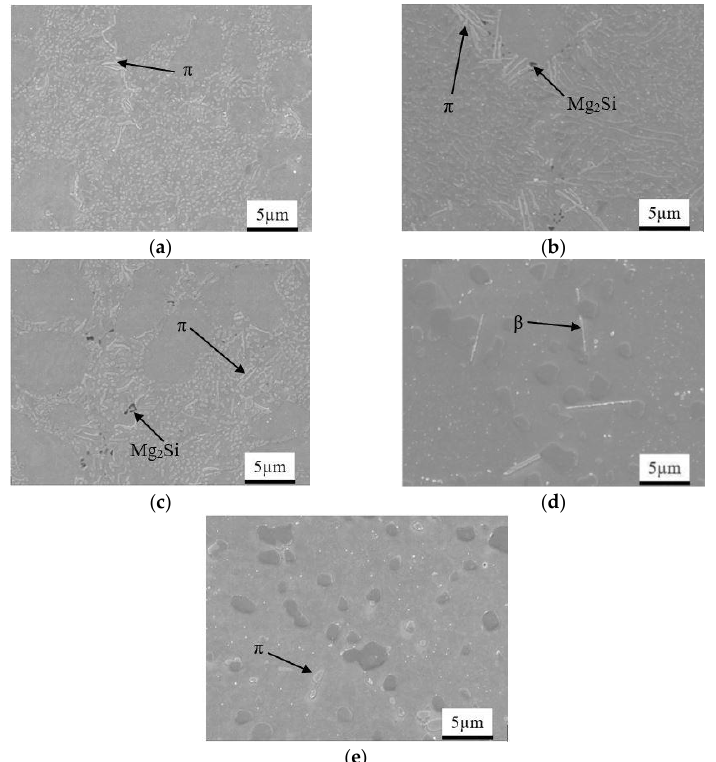
Figure 3. SEM images showing the eutectic microstructure of the surface layer of the ( a ) SSM Al – 7Si – 0.3Mg — T5, ( b ) SSM Al – 7Si – 0.45Mg — T5, ( c ) SSM Al – 7Si – 0.6Mg — T5, ( d ) SSM Al – 7Si – 0.3Mg — T6, and ( e ) SSM Al – 7Si – 0.45Mg — T6 castings.